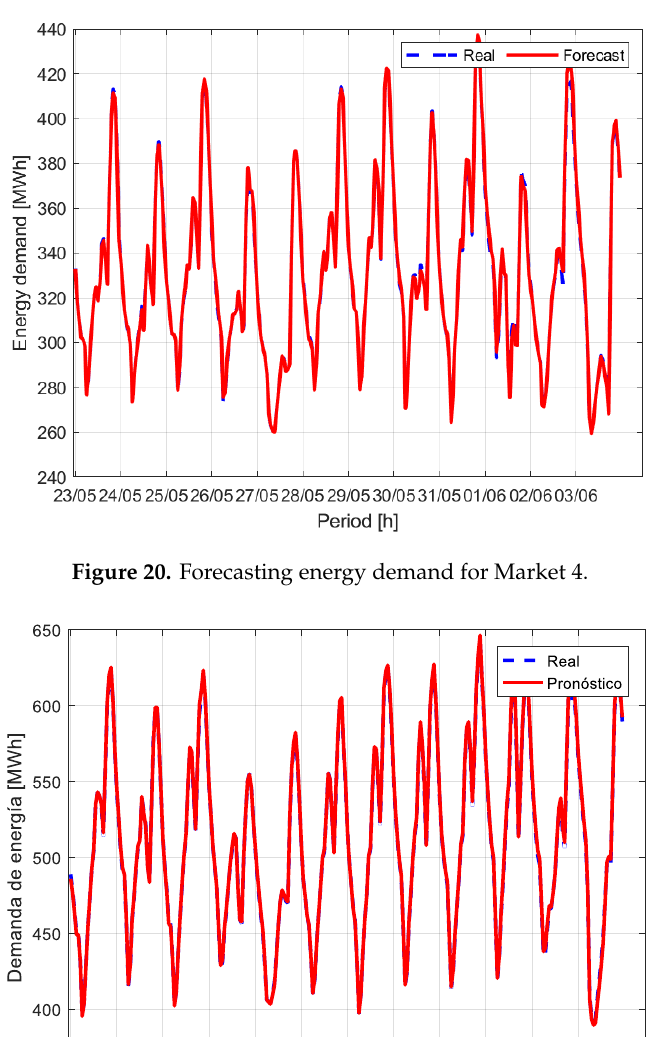
Figure 19. Forecasting energy demand for Market 3.